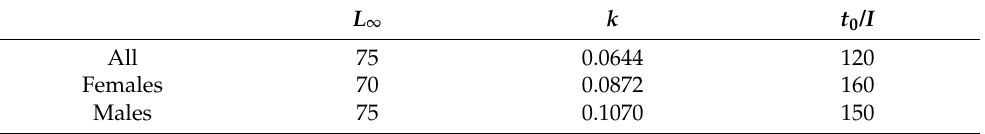
Table 1. Starting values of the growth models for all datasets and for each gender. L ∞ = the theoretical asymptotic length, t 0 = theoretical age when the body length is equal to 0, k = the growth rate at which SL approaches L ∞ whereas I = the age at inflection